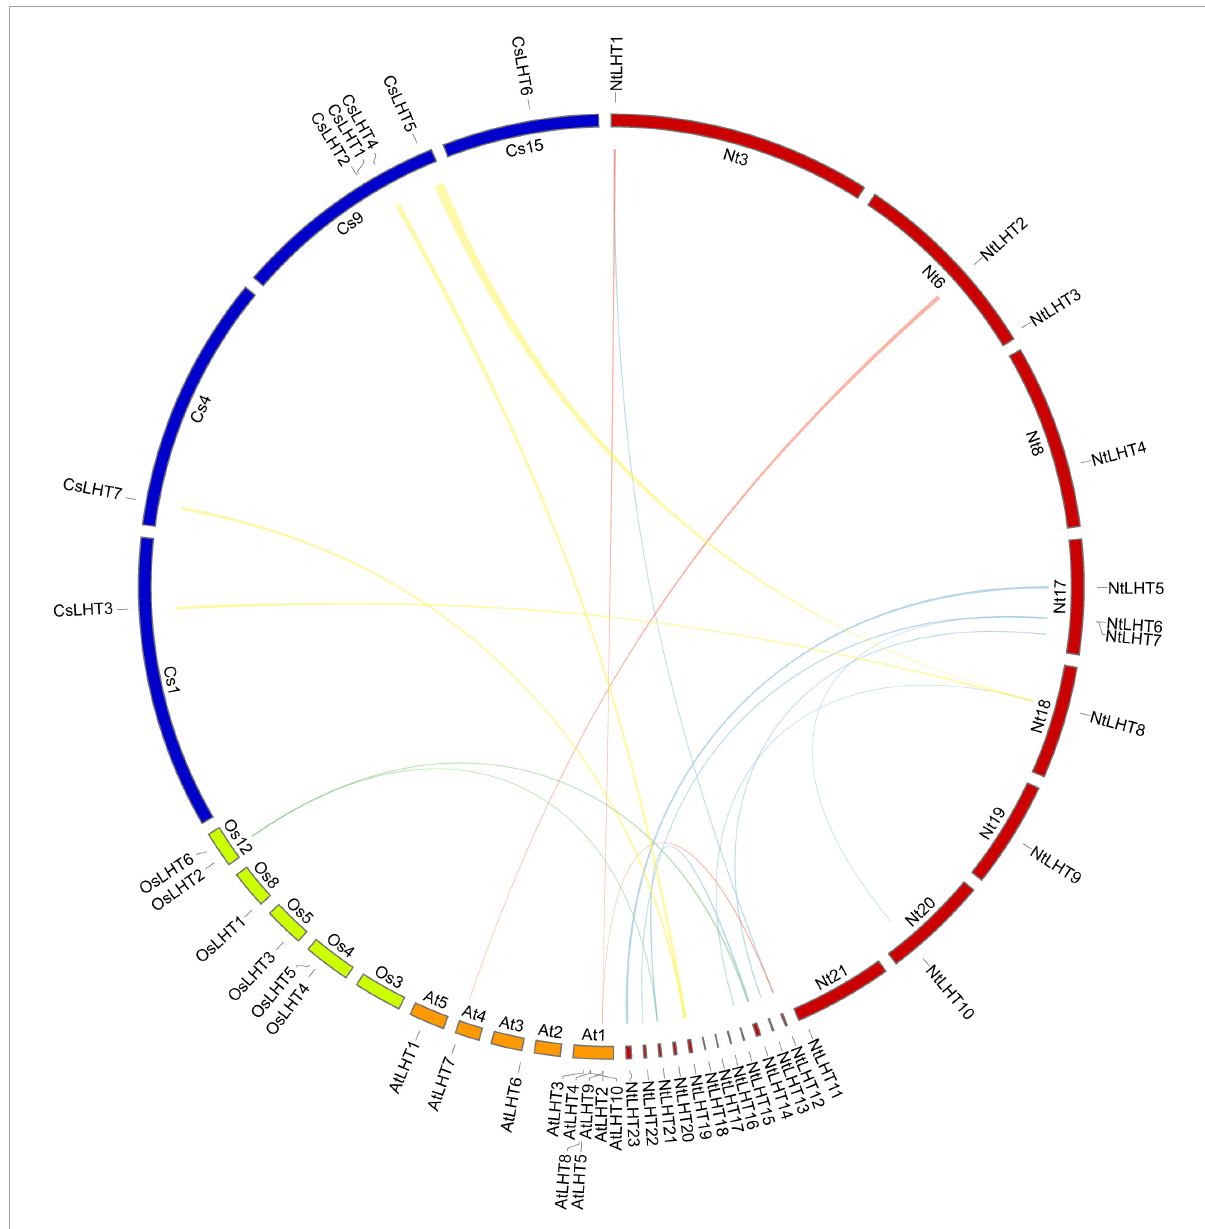
FIGURE4 Collinear analysis of LHT genes between tobacco, tea, Arabidopsis , and rice. Blue lines highlight the segmental duplicated NtLHT genes. Yellow, cyan, and red lines highlight the collinear gene pairs between tobacco and tea, tobacco and rice, tobacco and Arabidopsis ,